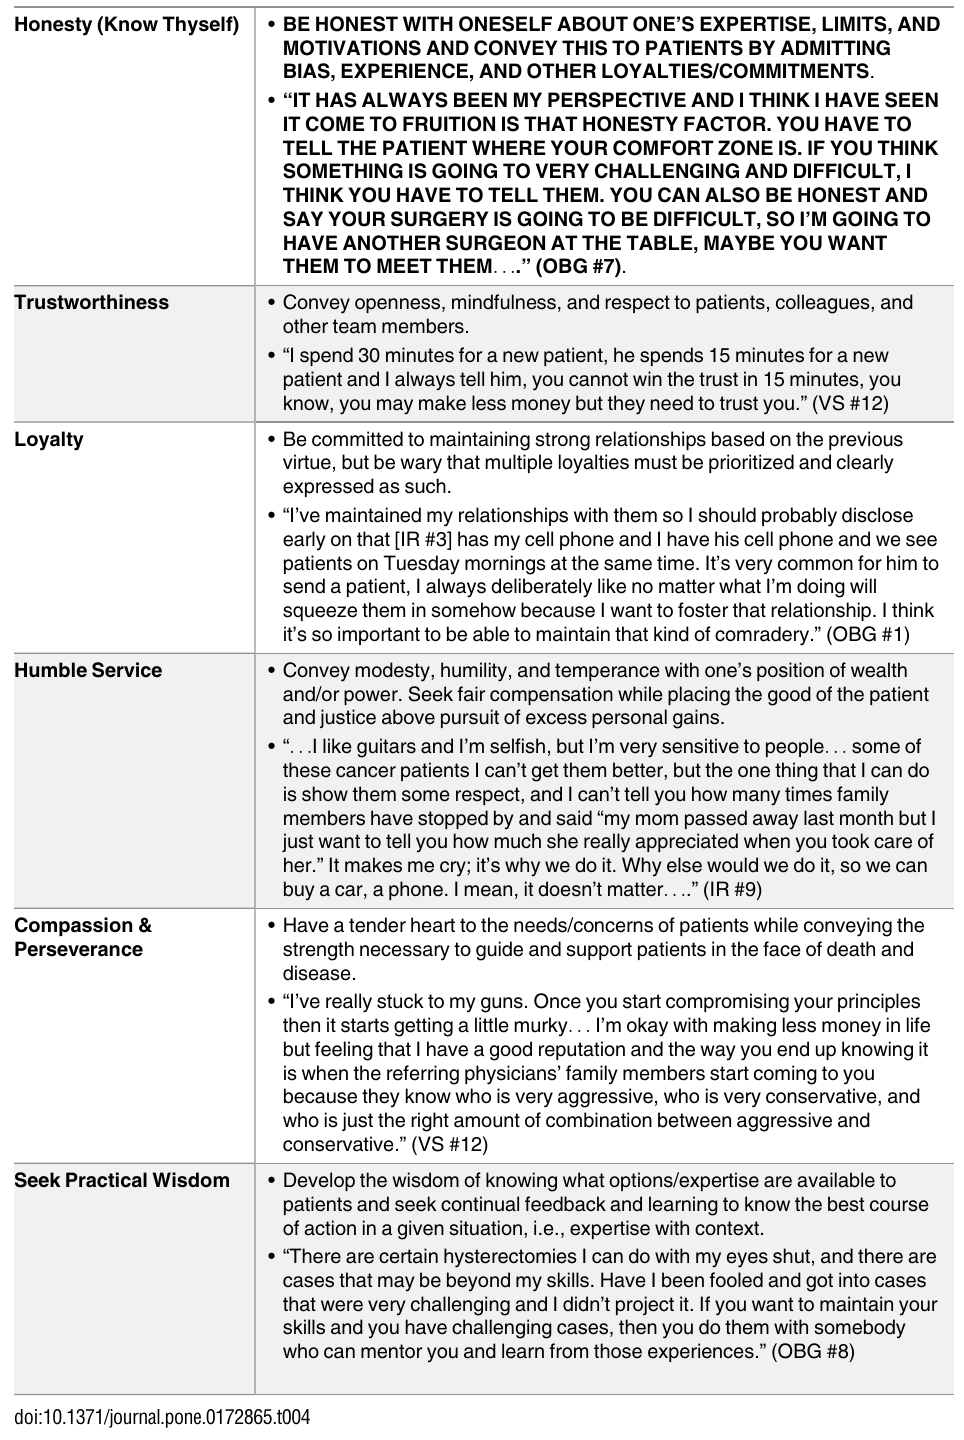
Table 4. Summary of common physician